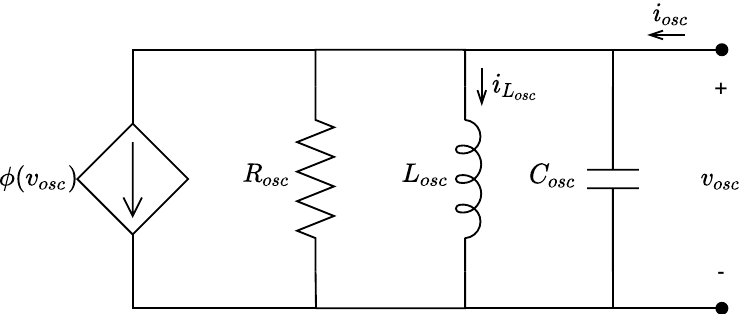
Figure 2. Oscillator example, compatible with Virtual Oscillator Control (VOC) method and used in this